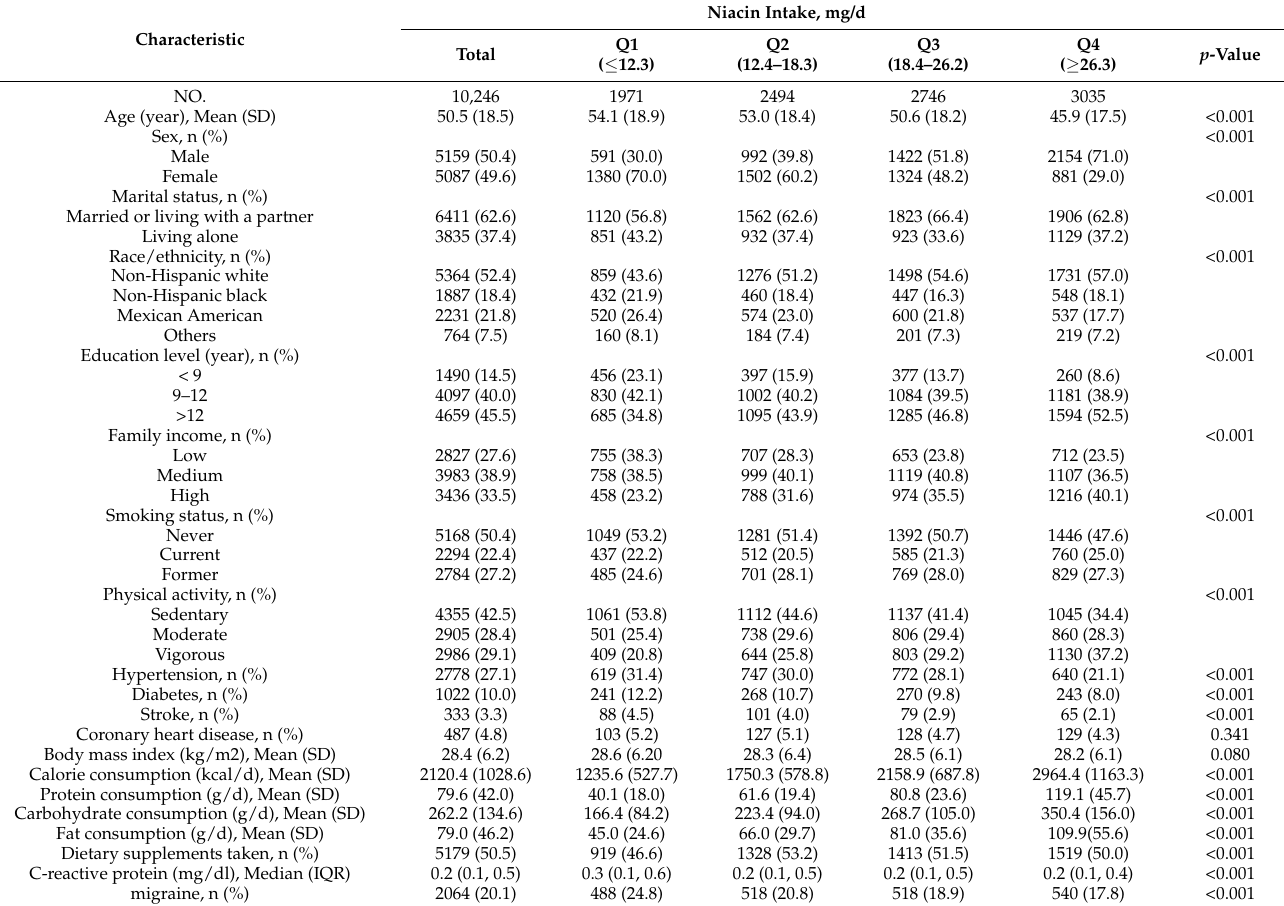
Table 1. Population characteristics by categories of dietary niacin